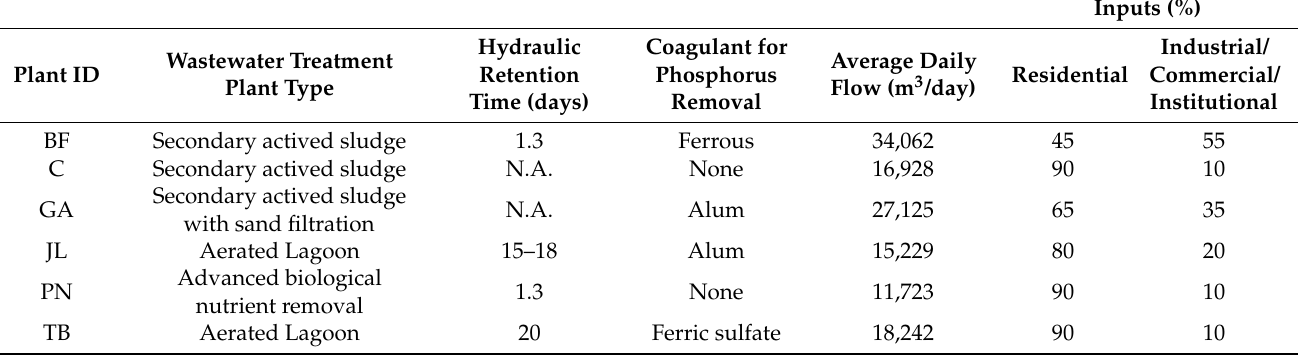
Table 1. Wastewater treatment process types.